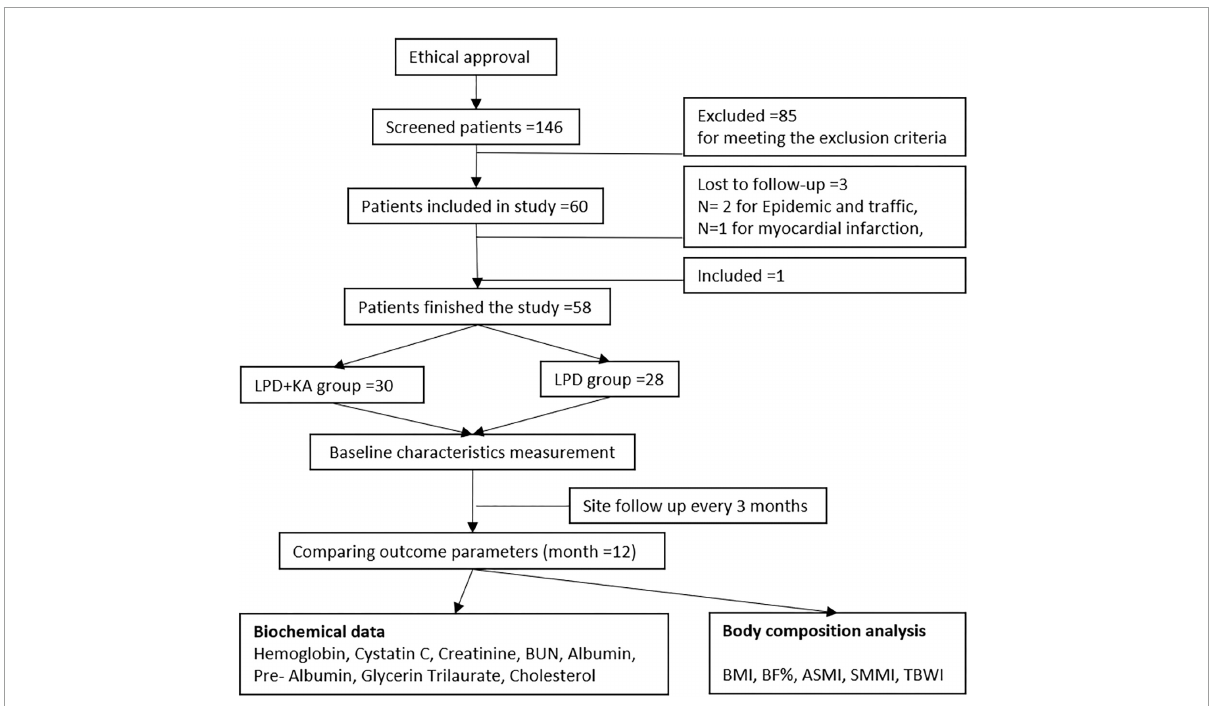
FIGURE1 Study methodological flow diagram. KAs, ketoacids; LPD, low-protein diet; BMI, body mass index; BF, body fat; SMMI, Skeletal Muscle Mass Index; ASMI, appendicular skeletal muscle mass index; TBWI, total body water